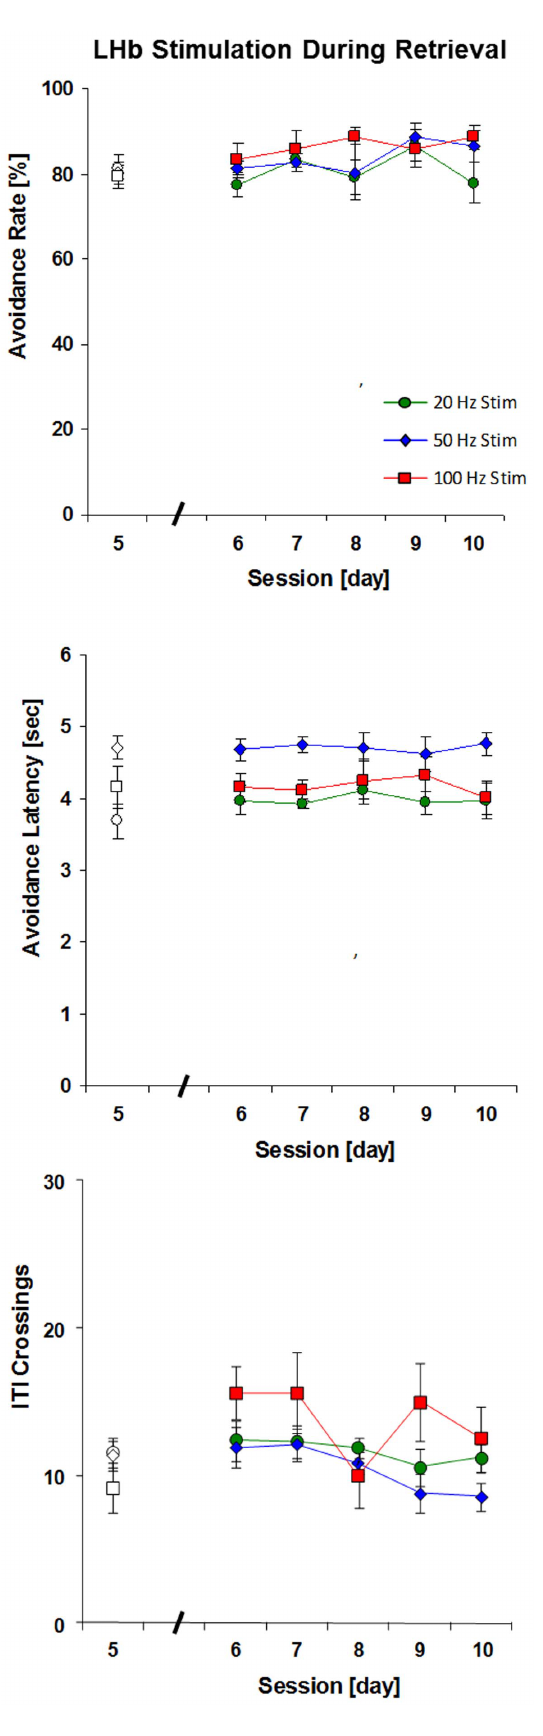
Figure 3. Effect of LHb stimulation on retrieval i.e., last five sessions. Open symbols indicate baseline performance before stimulation was